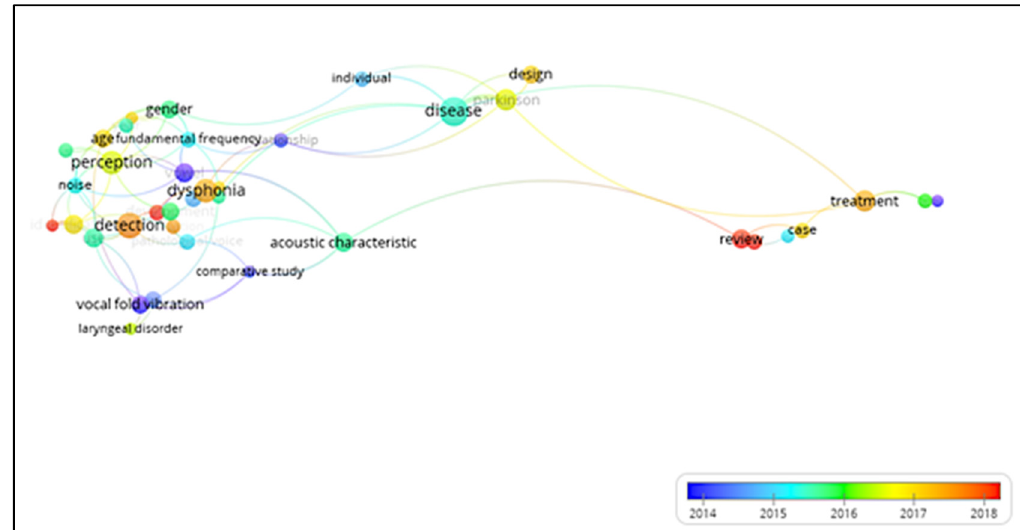
Figure 7. Keyword co-occurrence showing changes over the studied period. Blue colors identify the most-used terms in the initial part of the period.